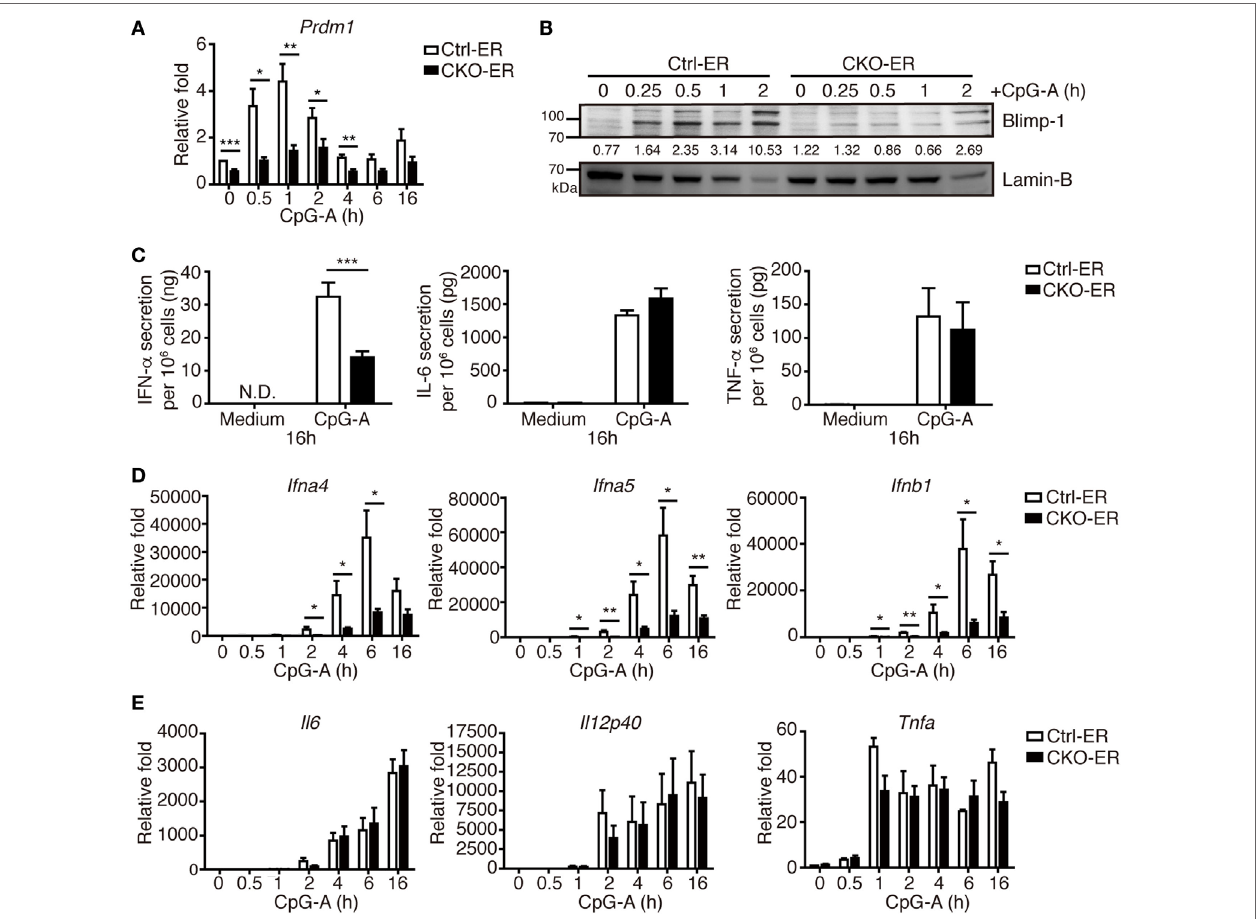
FigUre 4 | Inducible deletion of Prdm1 confirmed the important role of Blimp-1 in type I IFN (IFN-I) production in plasmacytoid dendritic cells (pDCs). (a,B) RT-quantitative PCR (RT-qPCR) (a) and immunoblotting (B) showing Blimp-1 mRNA and protein levels in FLpDCs from Ctrl-ER and CKO-ER mice treated with 500 nM 4-OHT and then stimulated with 1 µM CpG-A at indicated time points. The quantitation of Blimp-1 in (B) was presented by the ratios of Blimp-1 band intensity vs. Lamin-B band intensity at each time point. (c) 4-OHT treated FLpDCs cultured from Ctrl-ER and CKO-ER mice were stimulated with 1 µM CpG-A or medium alone for 16 h, followed by ELISA to measure the levels of IFN- α , IL-6, and TNF- α production. (D,e) RT-qPCR showing mRNA levels of IFN-I (D) and proinflammatory cytokines (e) in 4-OHT treated FLpDCs from Ctrl-ER and CKO-ER mice after stimulation with 1 µM CpG-A at indicated time points. Data represent the mean ± SEM and were analyzed by two-tailed unpaired Student’s t -test [ n = 6 in (a) , 3 in medium, 9 − 14 in CpG-A treatment in (c) , 7 in (D) , and 3 − 4 in (e) ]. * p < 0.05; ** p < 0.01; *** p <